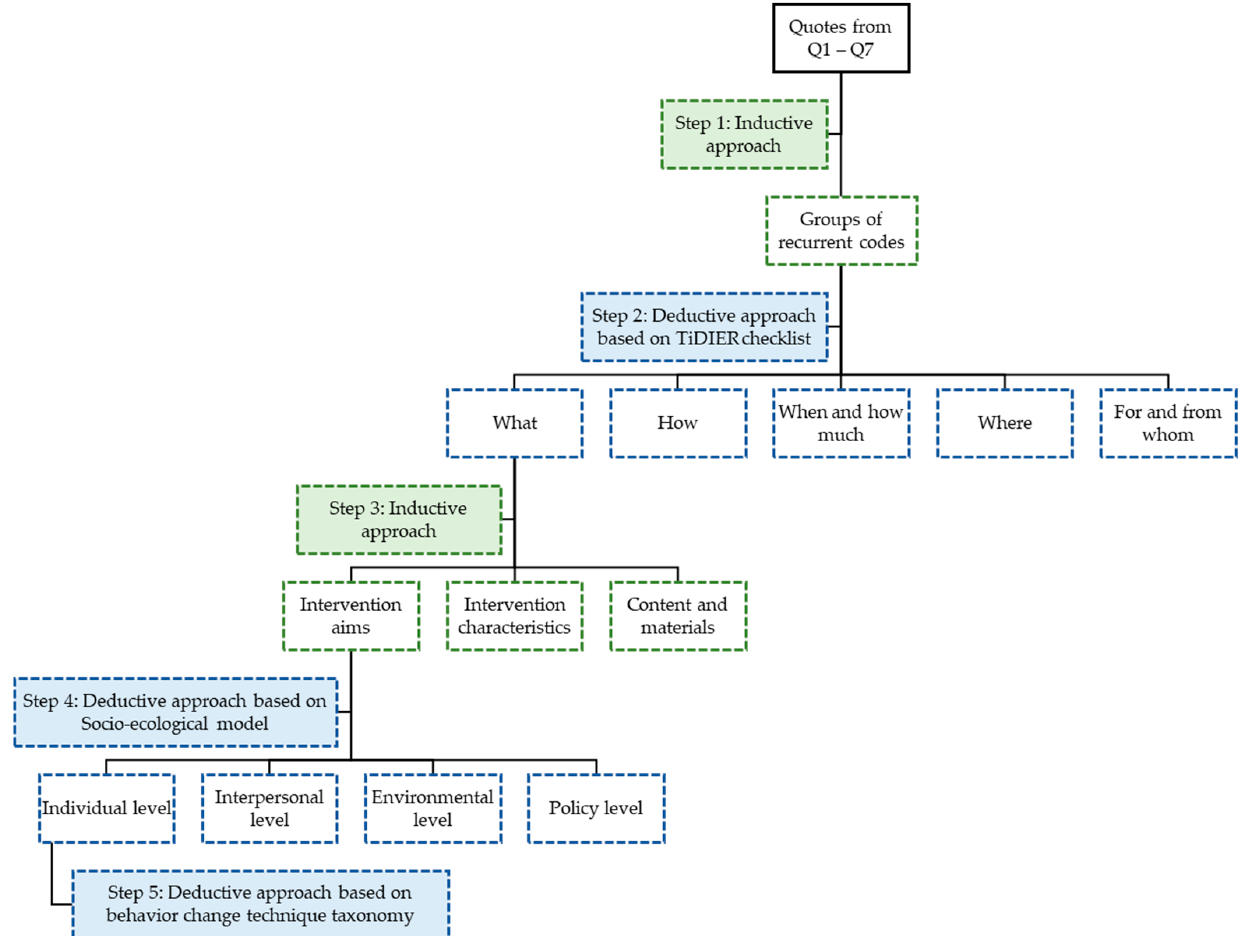
Figure 1 . Overview of the inductive—deductive data analysis of the focus group data. Q1–Q7: question 1—question 7. Deductive approach based on: TiDIER checklist [30], socio-ecological model [11] and behavior change technique taxonomy [31].